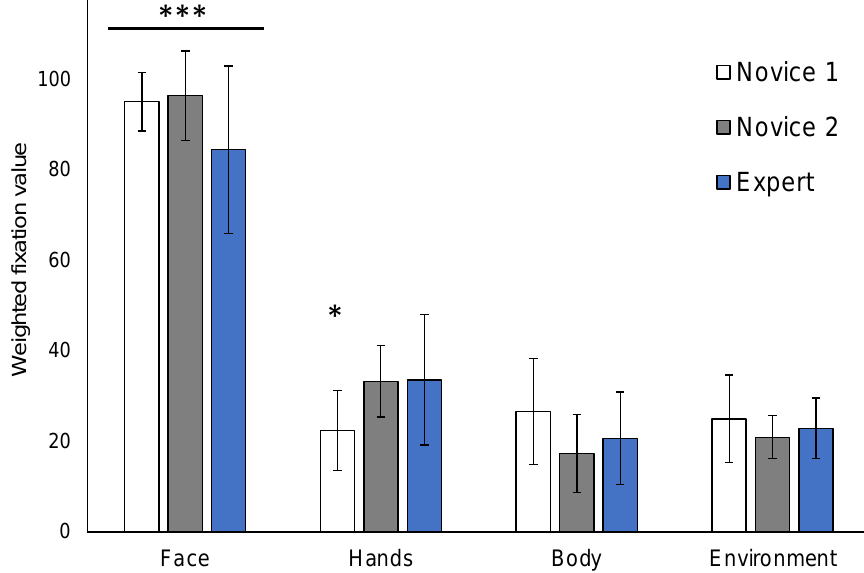
Figure 5. Average fixation order for target versus environment areas of interest among novice (Novice 1, Novice 2) and expert police. All participants fixated on faces earlier than hands, bodies, and the environment. Novice 1 participants fixated on hands significantly later than both Novice 2 and expert officers. *** p < 0.001, * p < 0.05.